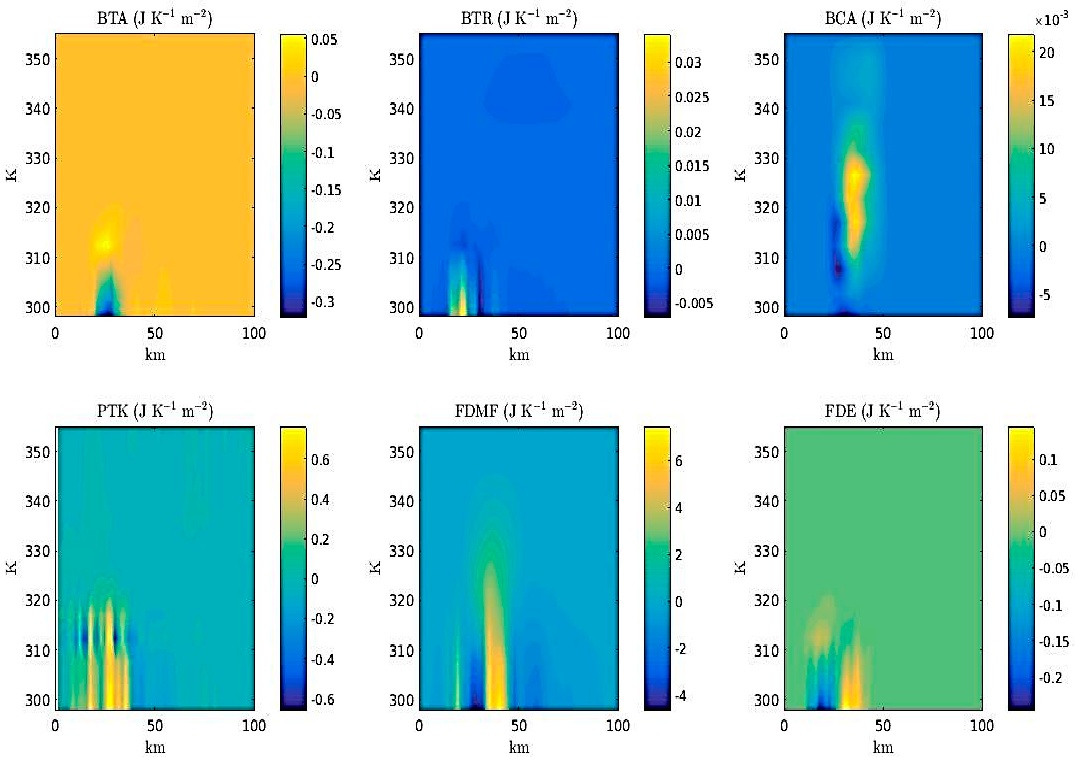
Figure 14. Same as Figure 13, except for (cid:1872) = 12